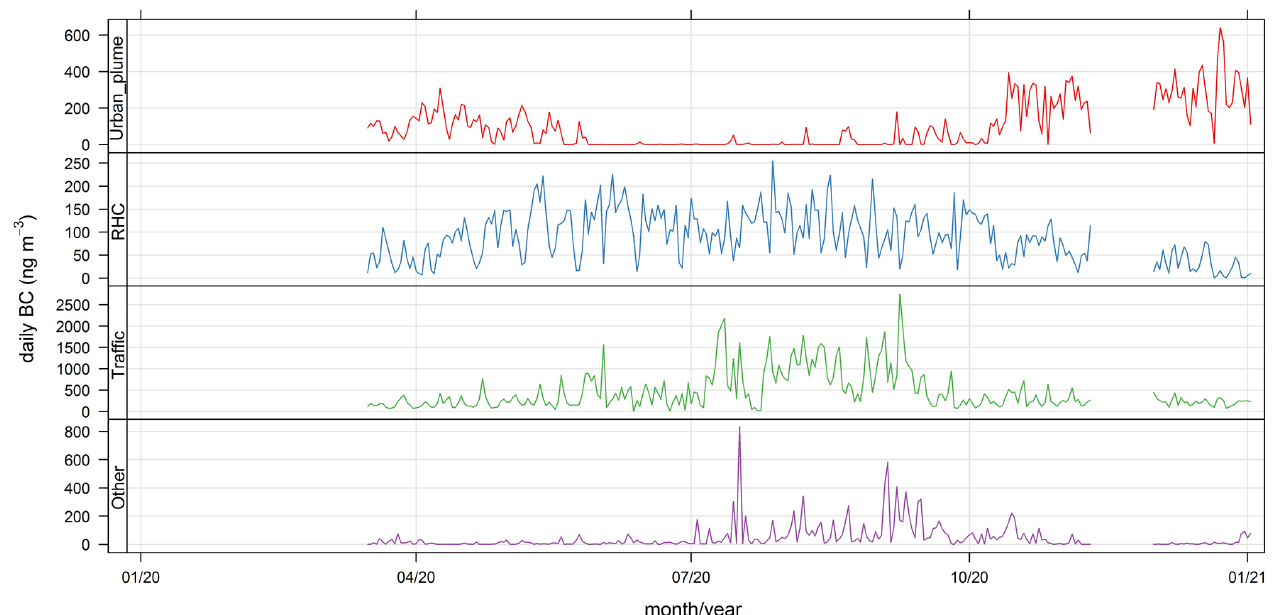
Figure 9. Time plot of daily source contributions to BC ff .